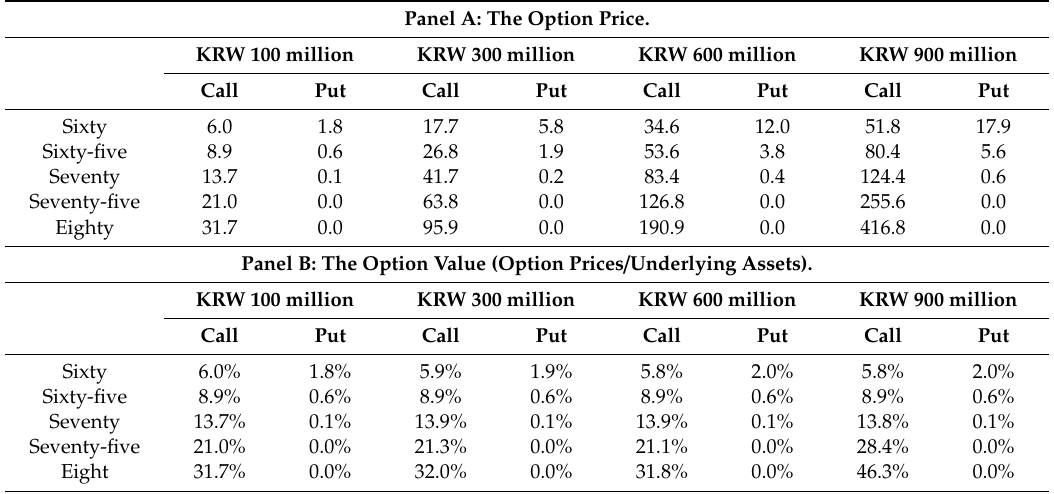
Table 3. Estimated option prices by age group and house price level. This table presents the estimated option prices and the options value for each age group and house price level. Panel A reports the call and put option prices. Panel B reports the call and put option values, in which the option prices are calculated by dividing by the underlying assets (house